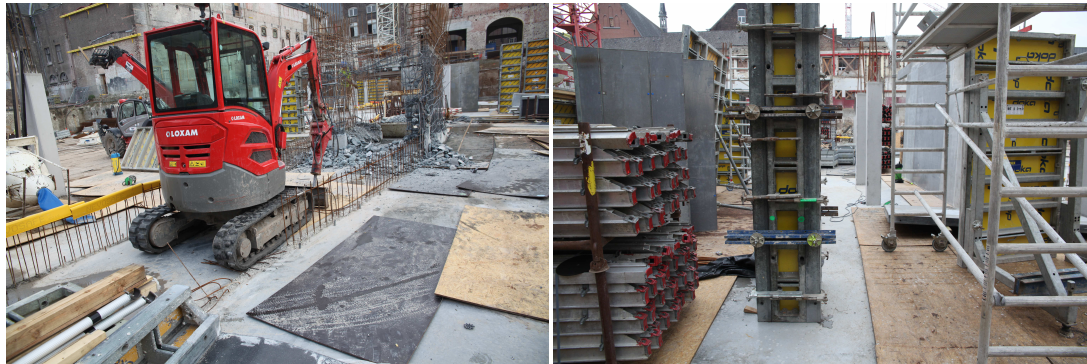
Figure 1: Auxiliary equipment and clutter on a construction site causing occlusions and registration